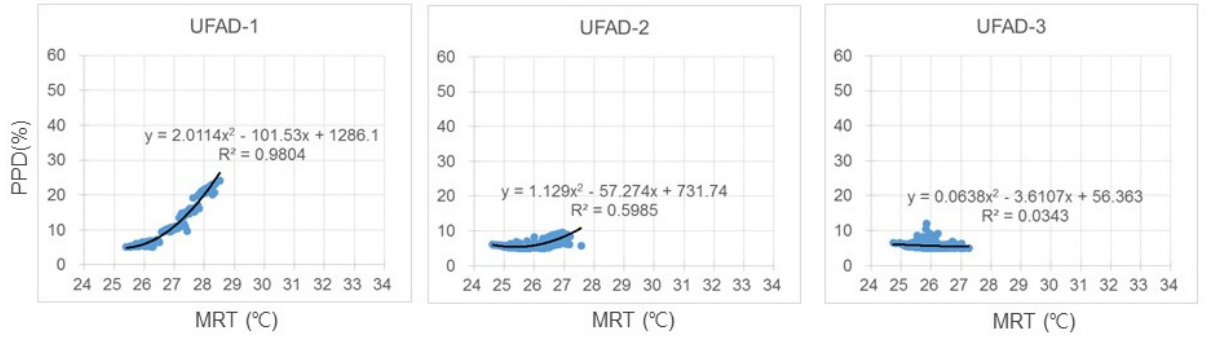
Figure 27. Correlation between MRT and PPD for